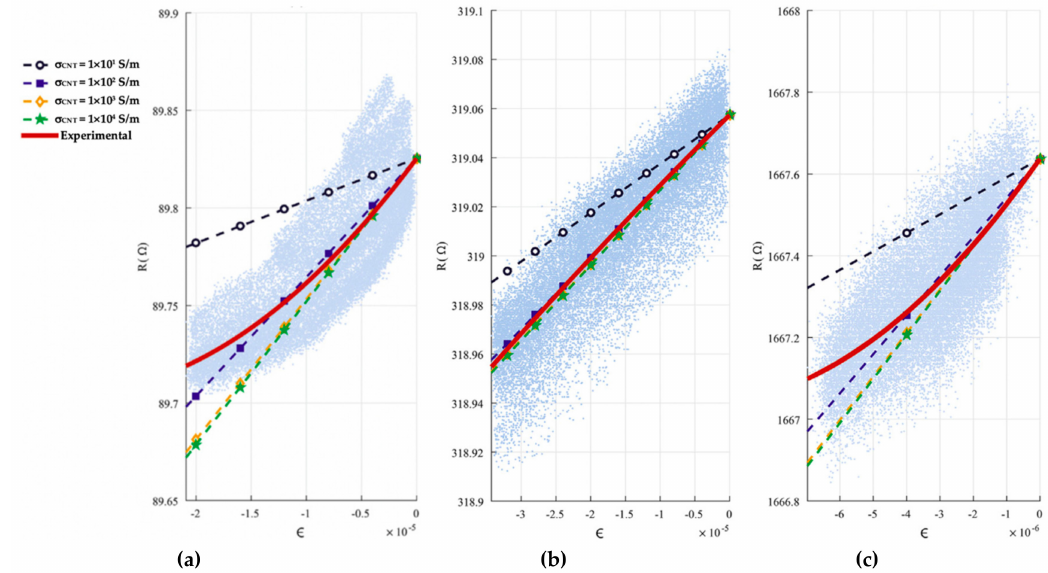
Figure 21. Results of the theoretical and experimental electrical resistance versus applied mechanical strain for ( a ) cement paste, ( b ) mortar and ( c ) concrete samples. Reprinted with permission from [124]. Copyright © 2017, Elsevier B.V.